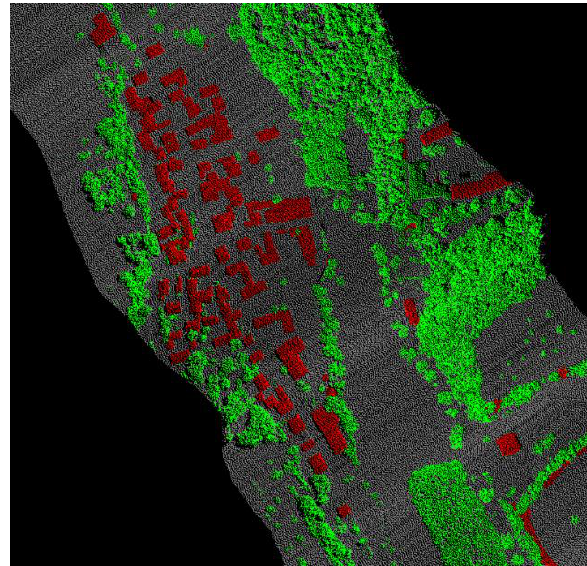
Fig. 4: Result CRF-classification (grey = ground , red = building , green = vegetation ).